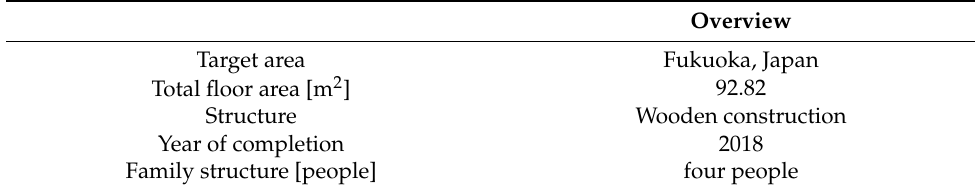
Figure 6. Plans and sections of reviewed house (unit: mm): ( a ) first-floor plan; ( b ) second-floor plan; red squares indicate the indoor wall where the heat storage wall is to be considered for Types B and C. In this paper, “Living + Dining + Kitchen room” refers to the Living room (yellow square, room volume: 63.53 m 3 ); ( c ) schematic cross-section. Table 2. Overview of the reviewed house.